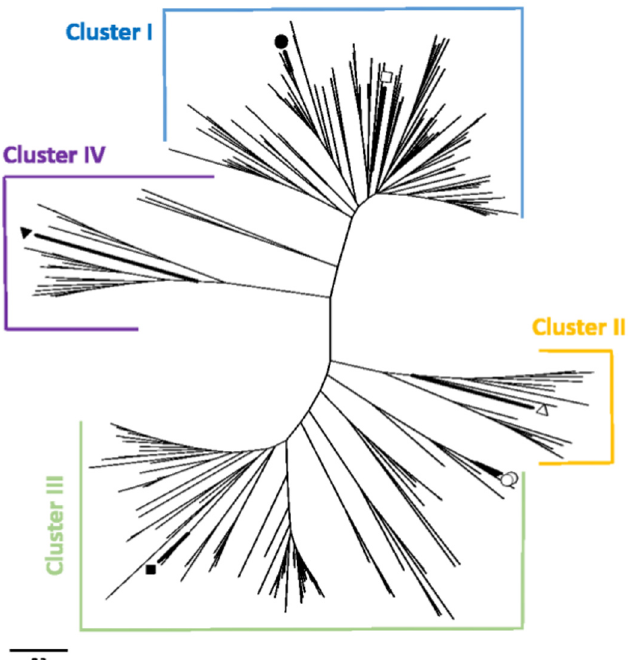
Fig 3. Phylogenetic tree of 231 fungal major intrinsic proteins (MIPs). The MIPs clustered into four distinct groups: Cluster I — putative water channels MIPs (represented by ADC55259| Saccharomyces cerevisiae [Black circle] and JF491353| Terfezia claveryi [black square]), cluster II — putative aquaglyceroporins MIPs that preferentially transporting small neutral molecules (represented by Lacbi2| 671860| Laccaria bicolor [open triangle]), cluster III — MIPs that putatively act as water and small neutral molecule transport channels (represented by GAA23030| S . cerevisiae [black rhombus]), and cluster IV — putative fungal X intrinsic proteins (XIPs) (represented by TmeAQP2| Tuber melanosporum [black triangle]). Both RdAQP1 and RdAQP2 (open circles) are located in Cluster III, pointing on their potential capability to act as a water channels. Bar represents 0.2